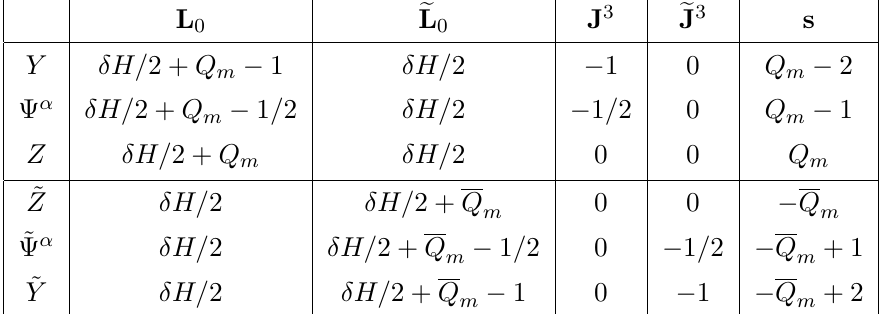
= 1 for fundamental particles. s